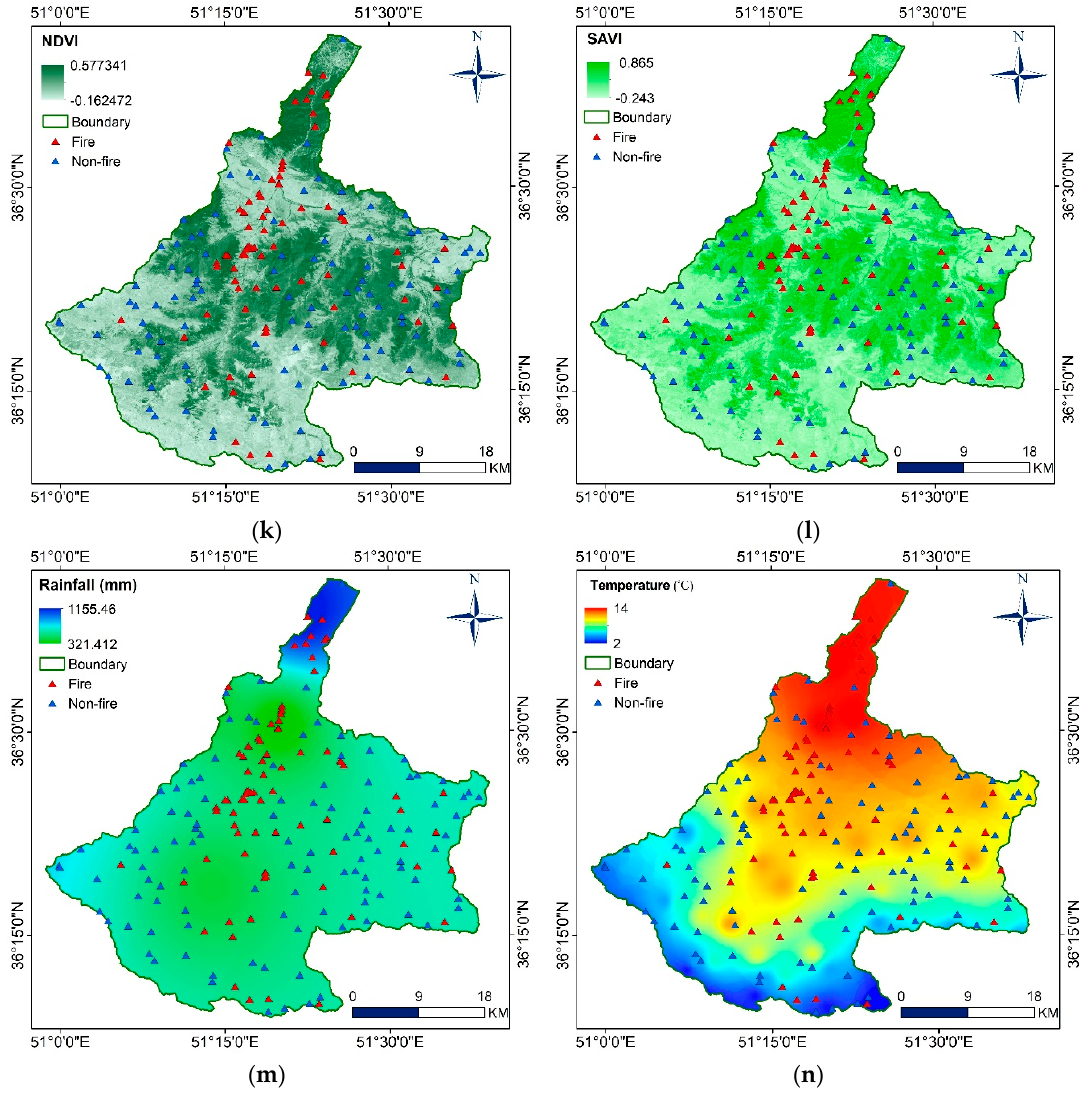
Figure 3. Forest fire conditioning factors: ( a ) altitude, ( b ) aspect, ( c ) slope, ( d ) curvature, ( e ) distance from river, ( f ) distance from road, ( g ) distance from residential, ( h ) LULC, ( i ) LST, (j) NDMI, ( k ) NDVI, ( l ) SAVI, ( m ) rainfall, ( n ) temperature.